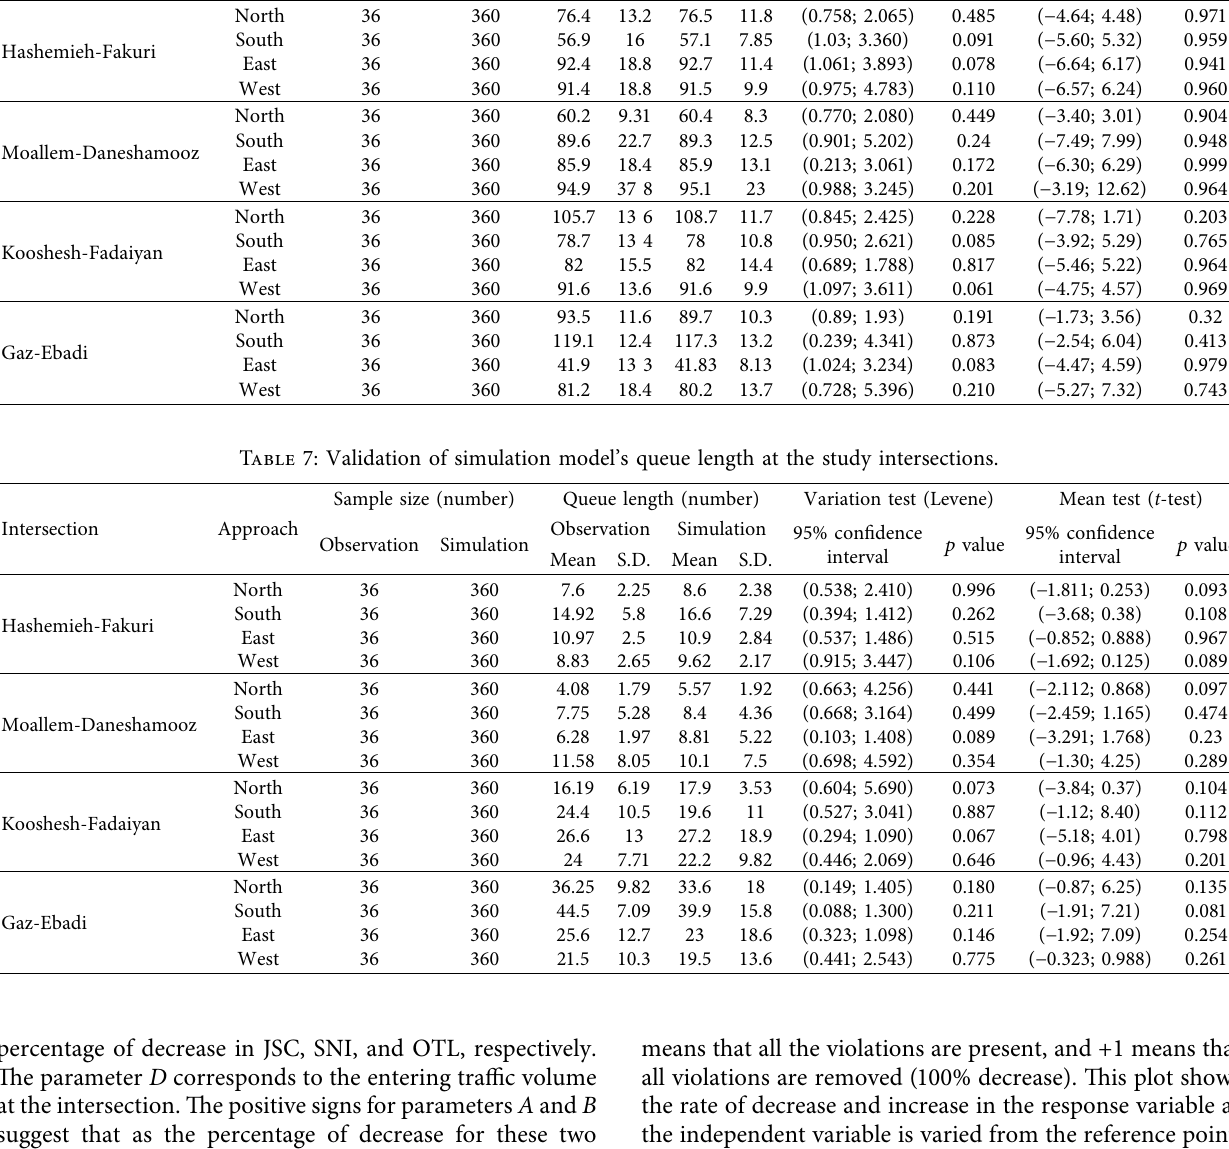
Table 6: Validation of simulation model’s trafc volume at the study intersections. Intersection Approach